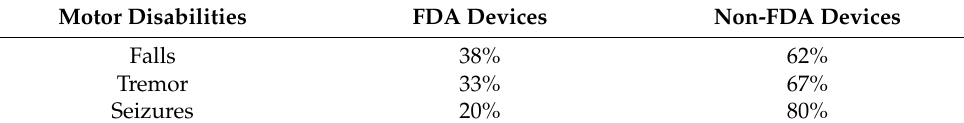
Table 8. NDD-Related Motor Impairments Monitored by Commercial Wearable Devices.